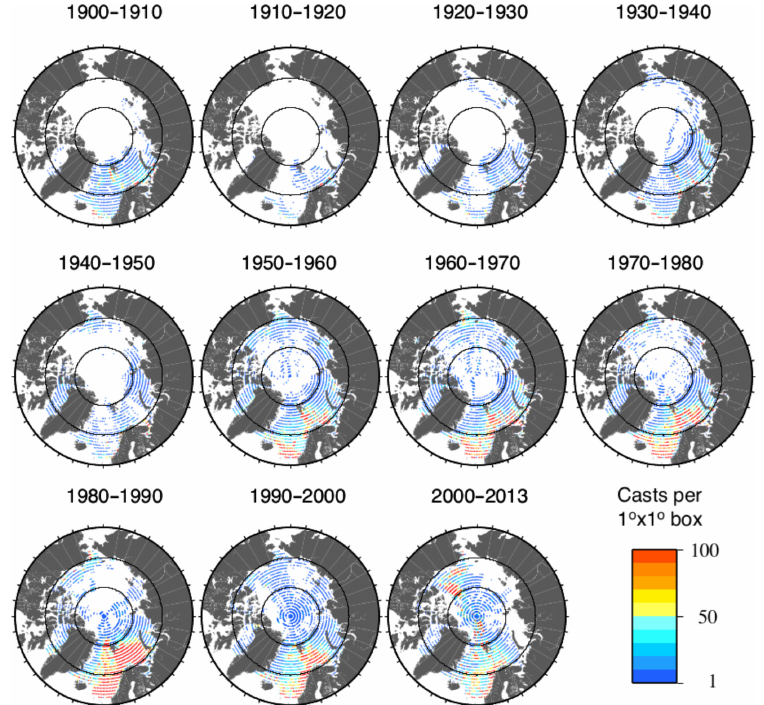
Figure 4. Data distribution by decade. Areas left white indicate no